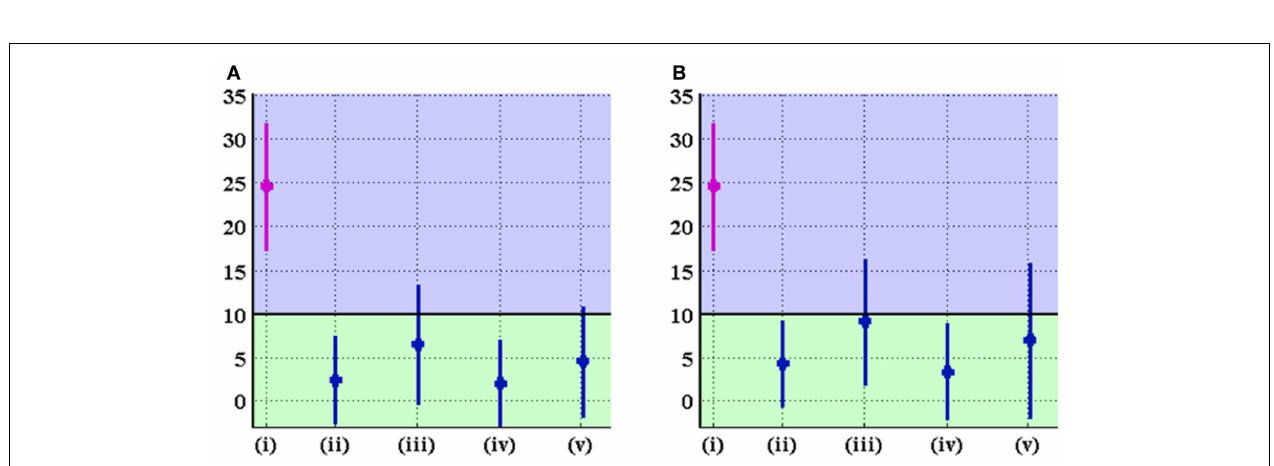
FIGURE 9 | CE angle (in degrees) in the original and optimal orientations of the acetabulum for (A) linear and (B) non-linear DEA .The graph displays mean ± standard deviation of measurements for each group.The groups denoted by (i), (ii), (iii), (iv), and (v) represent the original alignment and the optimal alignments found using uniform, p-b dysplastic, p-b normal, and